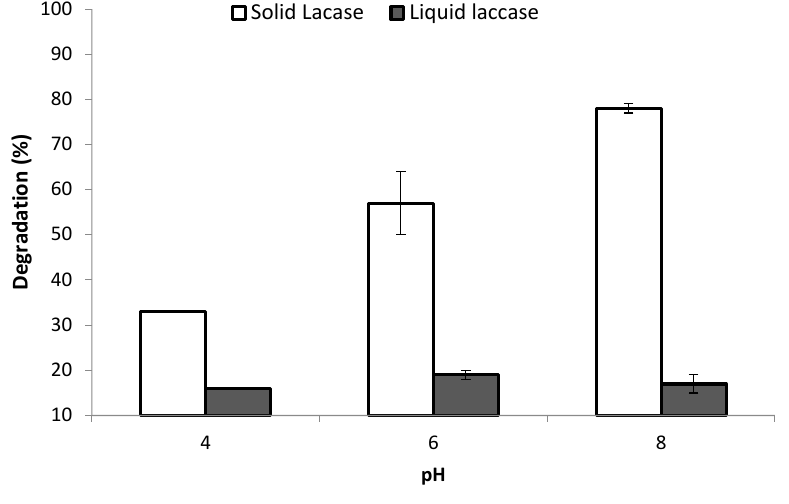
Figure 1. Degradation of phenolic compounds by laccase enzymes at different pH.